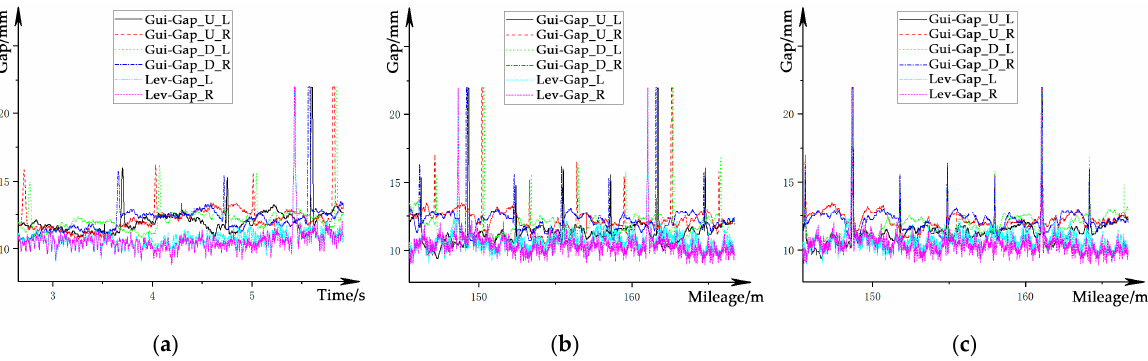
Figure 10. Processing of the gap signals: ( a ) gap signals in time domain; ( b ) gap signals in spatial domain; ( c ) synchronized gap signals in spatial domain.